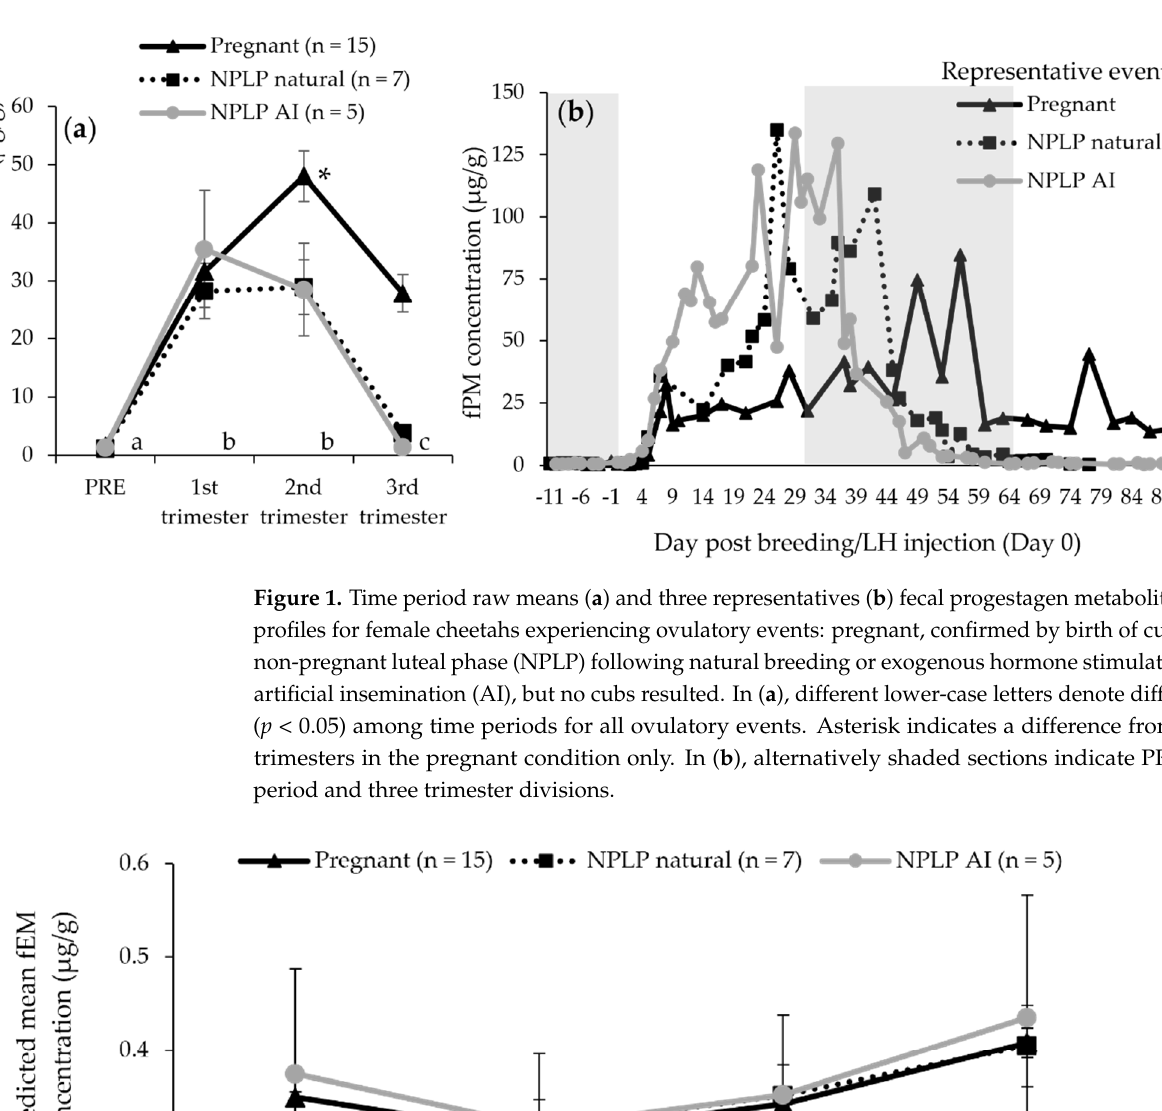
Figure 1. Time period raw means ( a ) and three representatives ( b ) fecal progestagen metabolite (fPM) profiles for female cheetahs experiencing ovulatory events: pregnant, confirmed by birth of cubs, or a non-pregnant luteal phase (NPLP) following natural breeding or exogenous hormone stimulation and artificial insemination (AI), but no cubs resulted. In ( a ), different lower-case letters denote differences ( p < 0.05) among time periods for all ovulatory events. Asterisk indicates a dif- ference from other trimesters in the pregnant condition only. In ( b ), alternatively shaded sections indicate PRE time period and three trimester divisions.